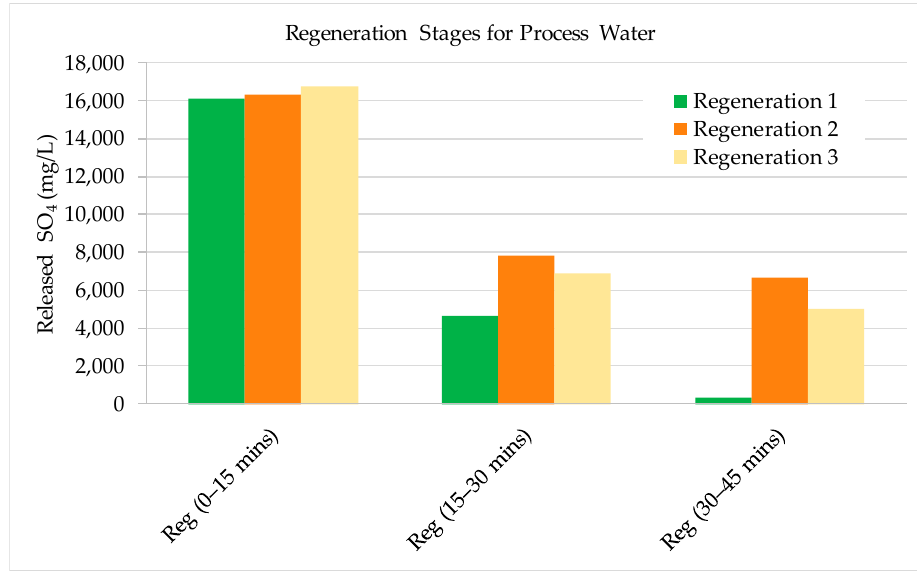
Figure 12. Desorption of sulphate ions from the resin in the regeneration stages applied after adsorption experiments on the Process Water.